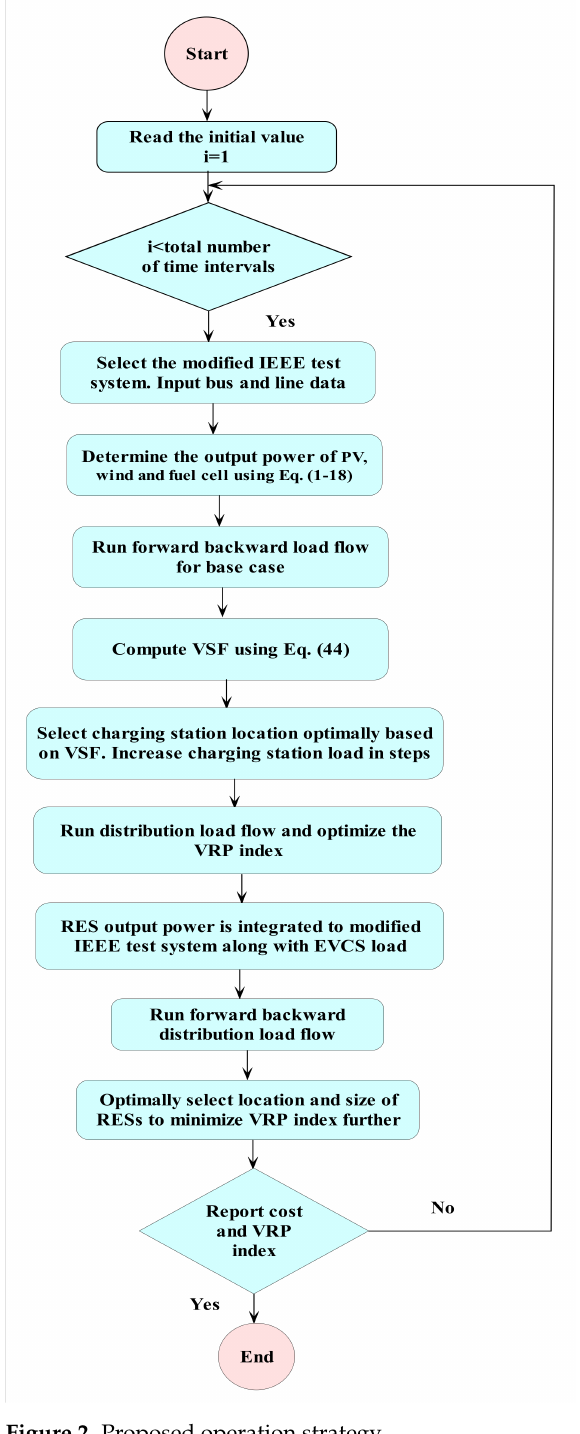
Figure 2. Proposed operation